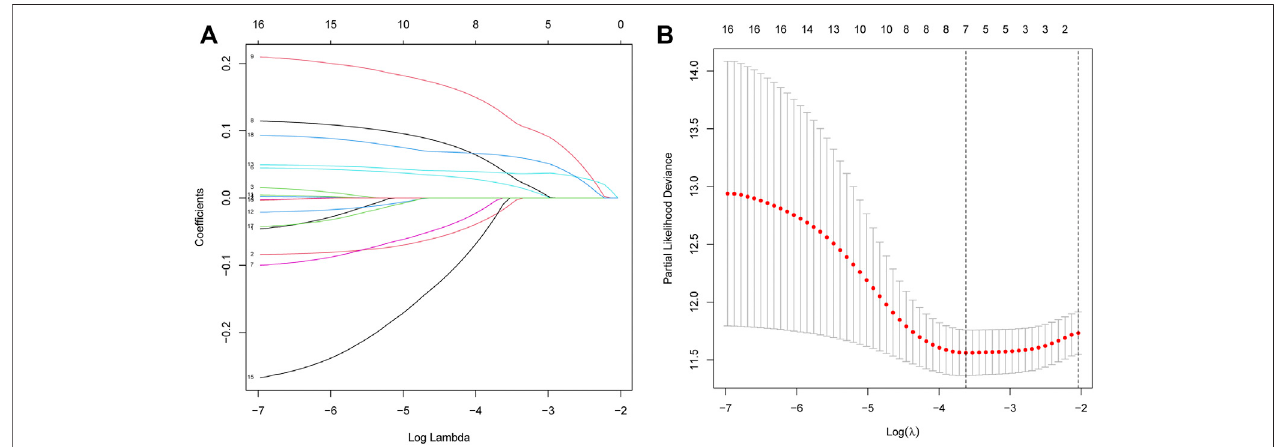
FIGURE 2 | Processes of LASSO Cox model fi tting. (A) . The log(lambda) sequence was used to plot the pro fi le of coef fi cients in the model at varying levels of penalization. (B) . Cross-validated error tenfold (the fi rst vertical line equals the minimum error, whereas the second vertical line shows the cross-validated error within a minimum of 1 standard error).